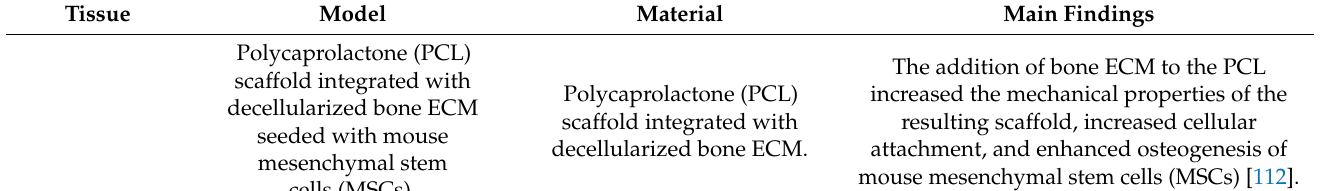
Table 4. Recent and noteworthy studies focused on cell–ECM–material interactions in